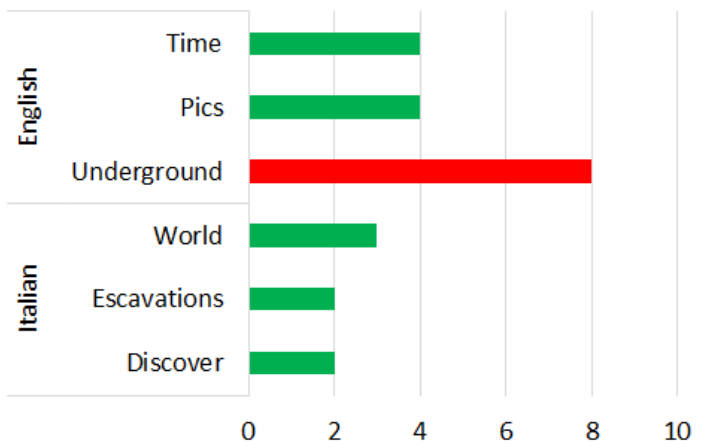
Figure 11. Percentage distribution of every primary emotion for English and Italian words during phase 3 of COVID-19 pandemic.